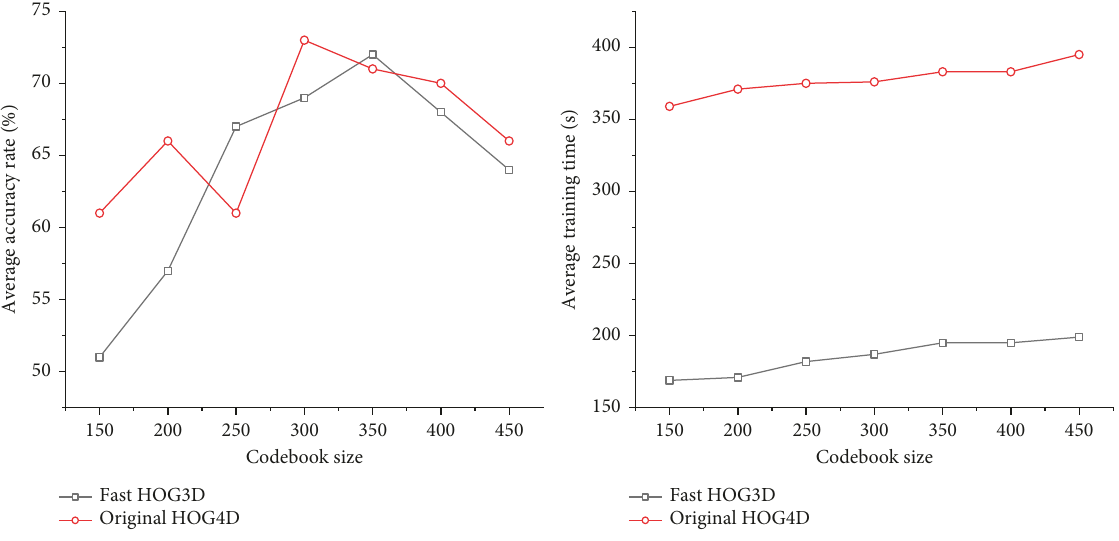
Figure 9: BoW-based recognition under different codebook Table 4: Fixed-point simulation parameters of broadband digital interference scenarios.